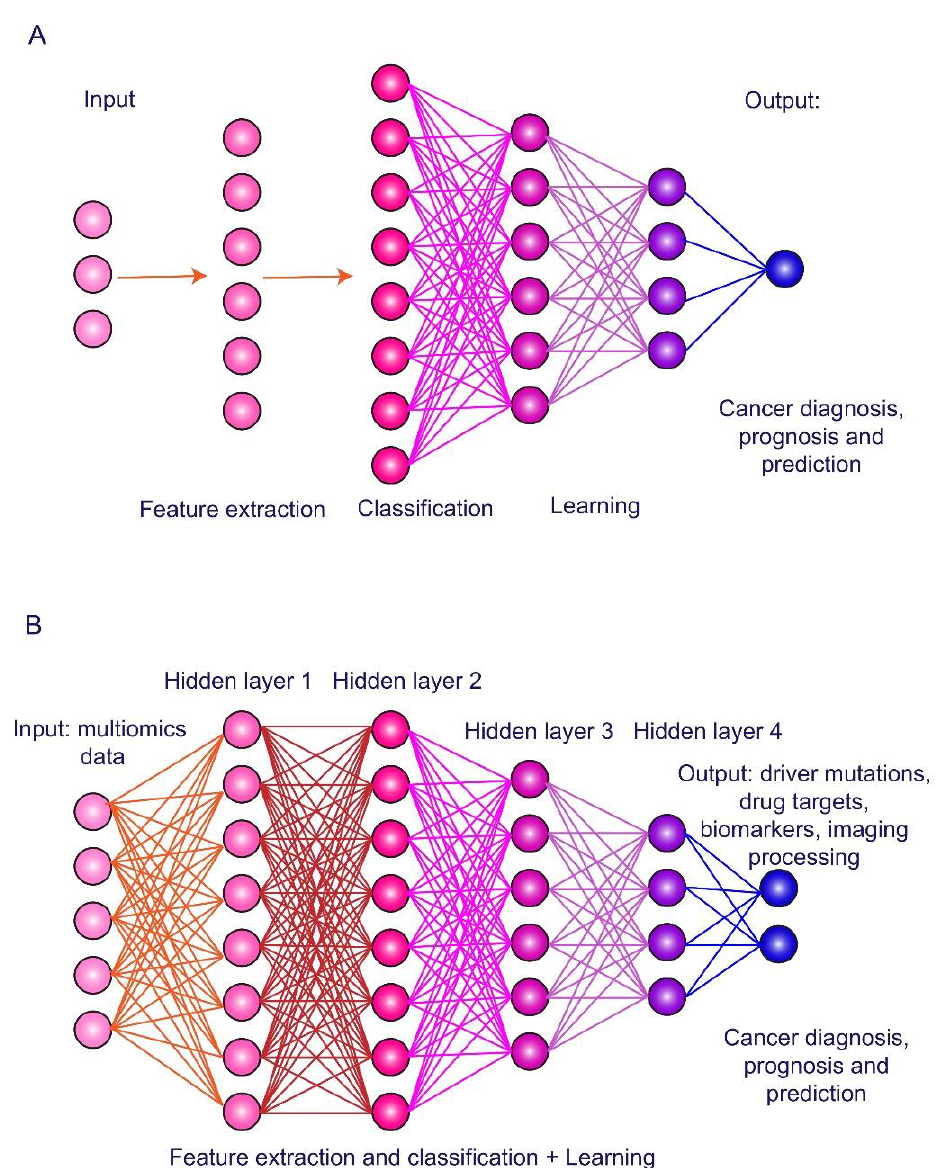
Figure 3. Principles of artificial intelligence technologies. ( A ) Machine learning is usage of computer algorithms to learn from an experience and to build predictive models based on training data. ( B ) Deep learning is data representation learning through artificial neuronal networks and multiple layers for feature extraction and classification to object recognition and decision making. Multiomics profiling and imaging data can be used as inputs, while identification of driver mutations, drug targets, plasma biomarkers, and image processing are outputs for hepatocellular carcinoma diagnosis, prognosis, and prediction.